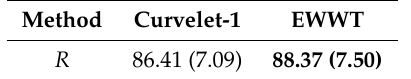
Table 4. Final comparative results for texture segmentation (best score in bold).